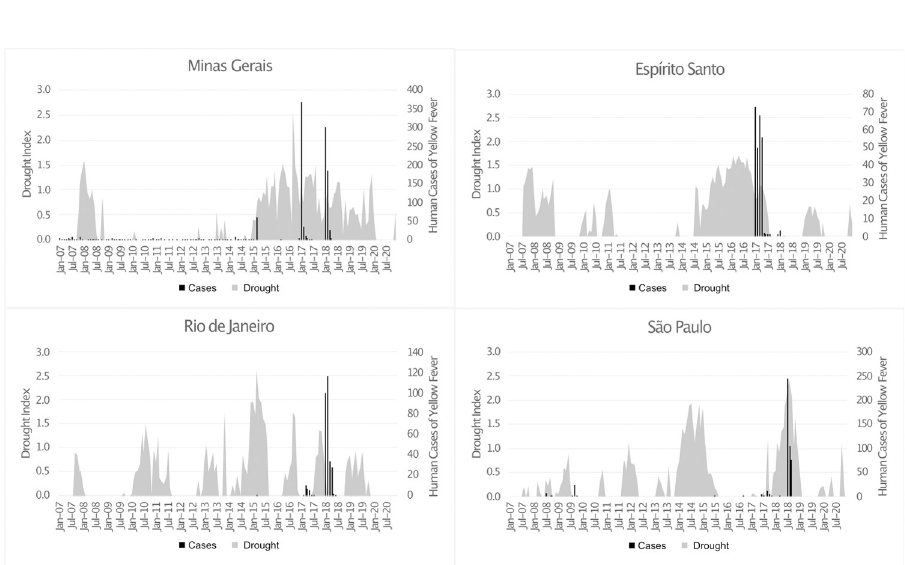
Fig 3. Timing of drought & yellow fever virus outbreaks. Abbreviations: Jan = January; Jul = July. The "Drought Index" is derived from the Standardized Precipitation Evapotranspiration Index (SPEI) which measures water balance based on rainfall and temperature. A negative value of SPEI indicates a water deficit; a negative SPEI is represented here by grey bars showing an increased drought index. The number of yellow fever virus cases reported in each state is represented by the black bars. Yellow fever virus outbreaks coincided with severe drought conditions in each of the four southeastern states of Brazil.